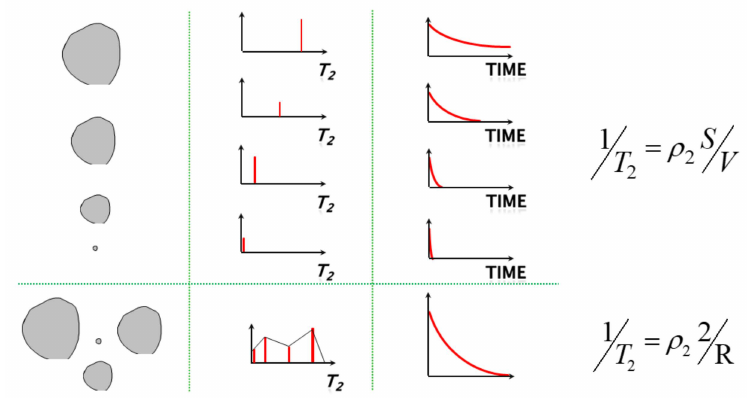
Figure 13. Relaxation time attenuation curve of porous